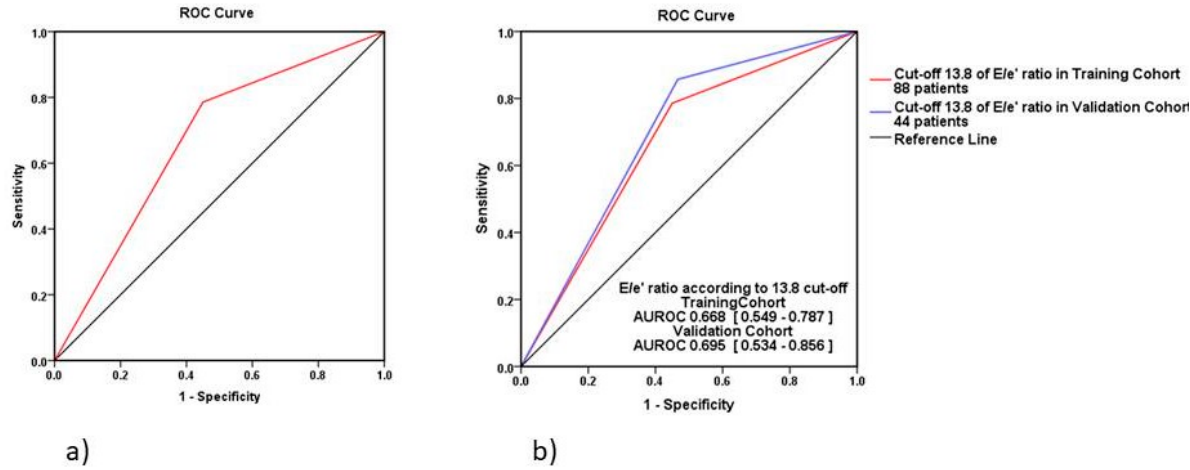
Figure 3. Receive operating curve of HFR at 6 months for E/e’ ratio. ( a ) ROC curve of HFR at 6 months for E/e’ ratio of 13.80 (n = 88); ( b ) ROC curves of HFR at 6 months for E/e’ ratio > 13.80 of the training cohort (n = 88, AUROC = 0.668) and validation contingent (n = 44, AUROC = 0.695). The two AUROC show close values and no significant differences among them (Hanley & McNeil test, p = 0.72).